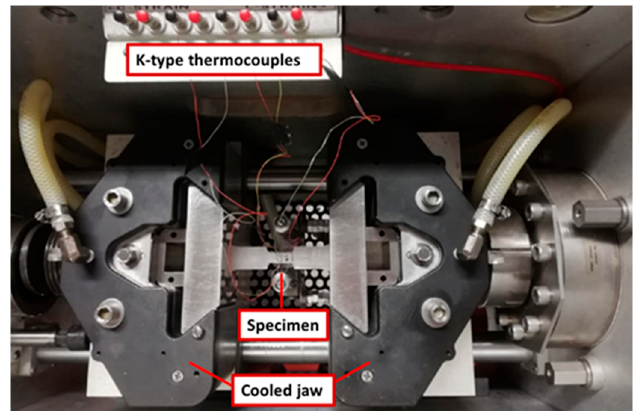
Figure 10. Experimental setup for Gleeble tests.